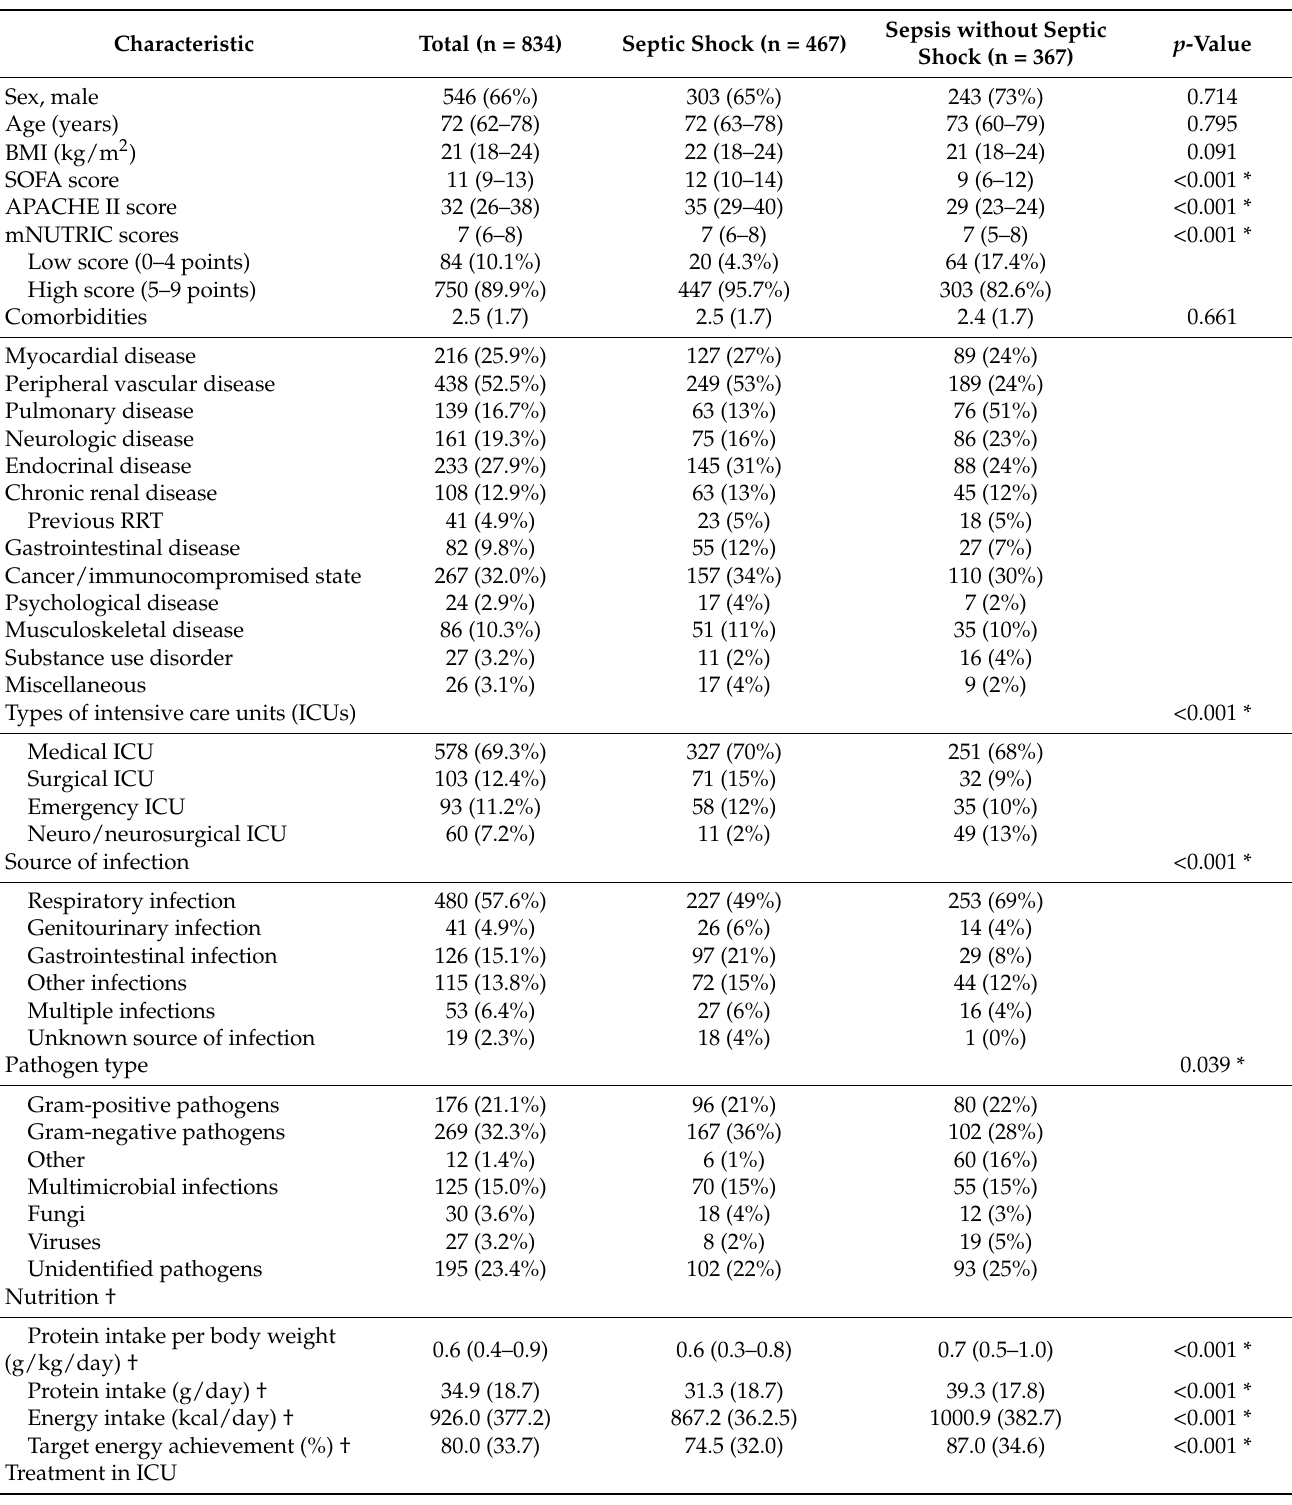
Table 1. Baseline characteristics and clinical outcomes of